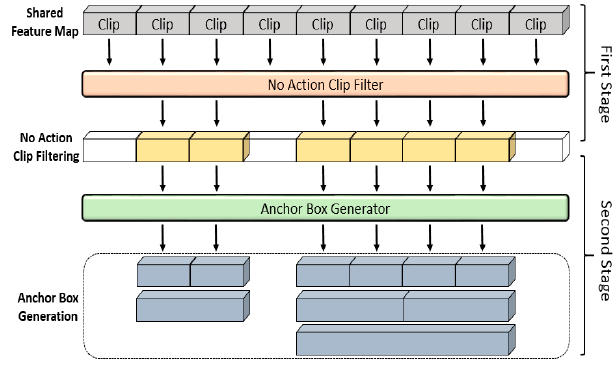
Figure 4. Temporal region proposal.